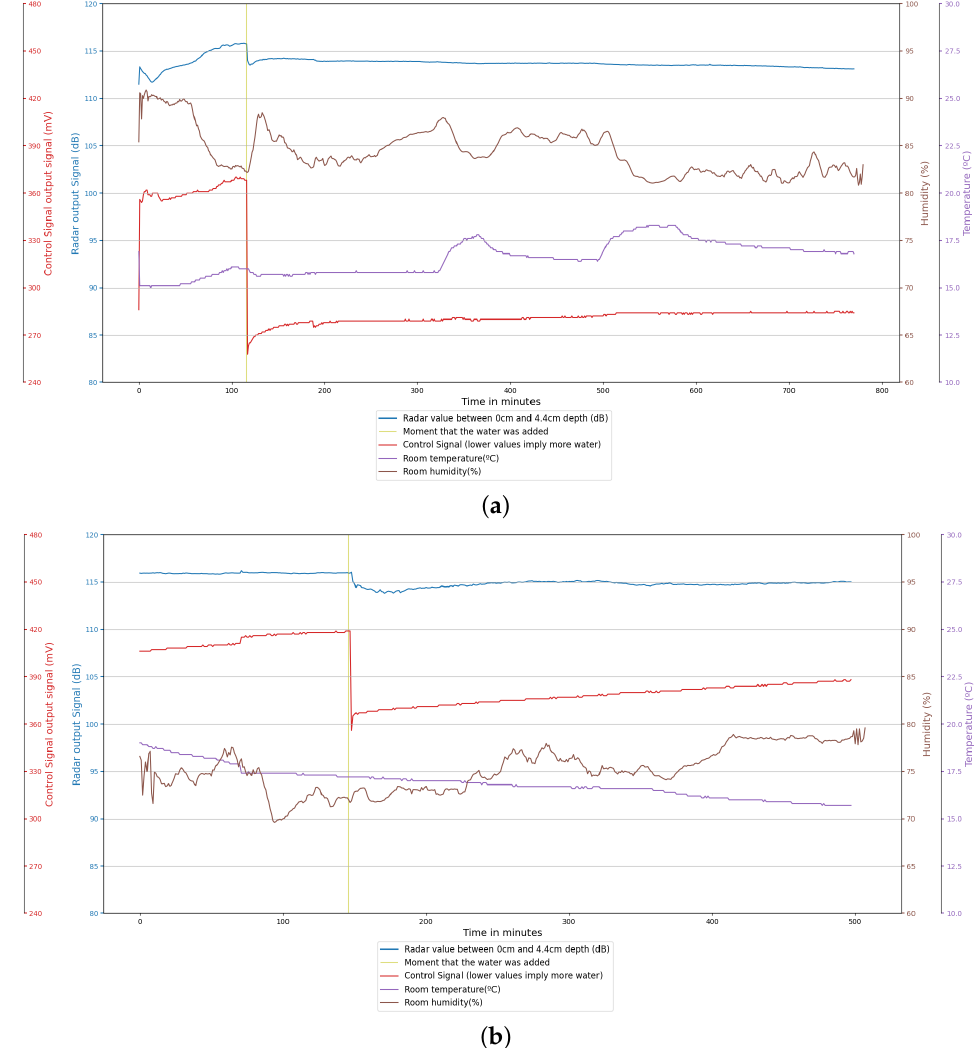
Figure 3. Experiment 1 results in a small container in two rounds. The blue line corresponds to the RADAR’s signal, and the red line corresponds to the control signal. The room temperature is the purple line and the brown line corresponds to the room humidity. The vertical yellow dotted line represents the moment when the water was added. ( a ) First round. ( b ) Second